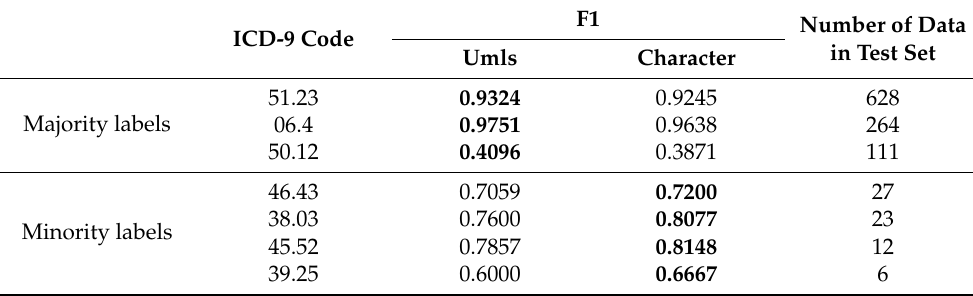
Table 5. Comparison of the F1 score by labels.